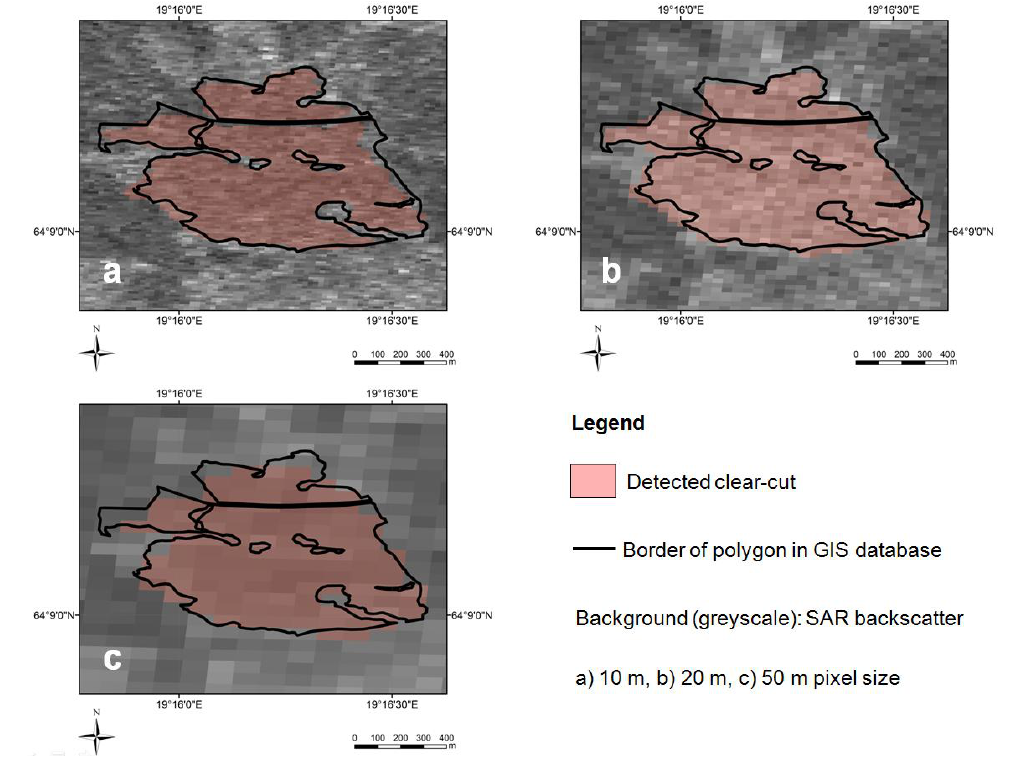
Figure 3. Example of a detected clear-cut using ALOS PALSAR data (in red) at ( a ) 10 m, ( b ) 20 m and ( c ) 50 m pixel size. For reference, the border of the clear-felled area is outlined as recorded in the GIS database provided by the company Sveaskog. As background, a PALSAR image acquired after clear-felling is used.